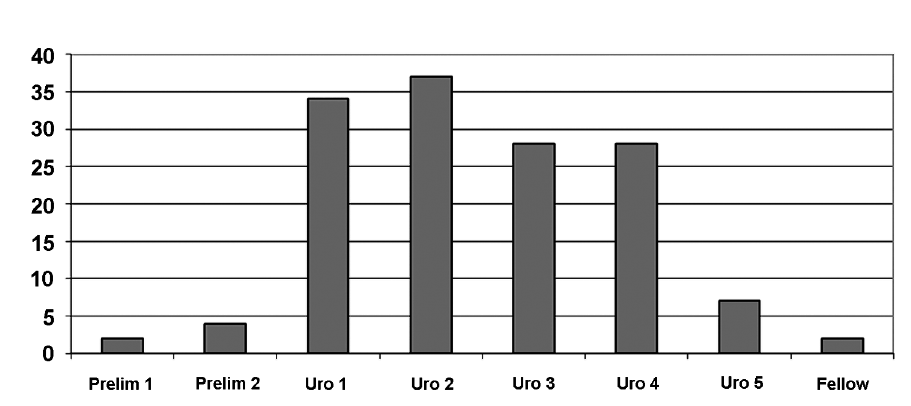
Figure 2 – Post-graduate year of residents that completed the survey.